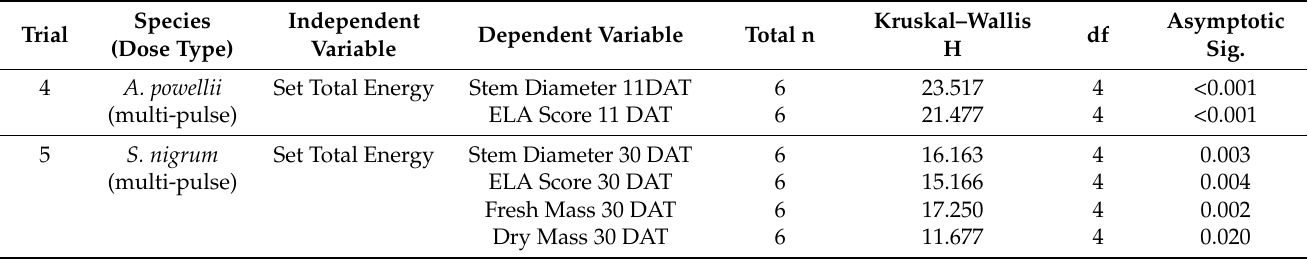
Table 7. Statistical Summary of Independent Samples Kruskal–Wallis Test for a range of biometric factors of A. powellii and S. nigrum plants 15 days after receiving multiple pulse electric